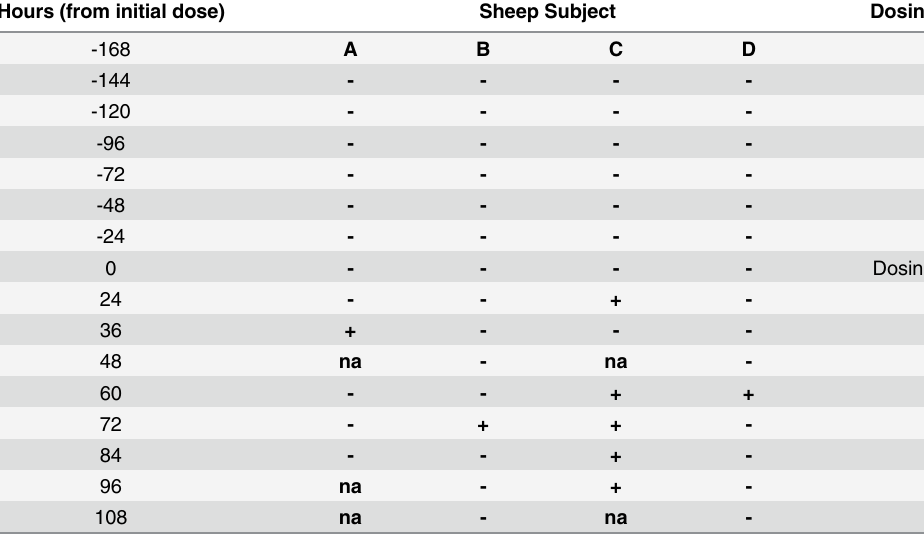
Table 2. Transit of S . fimicola CID 323 through the gastrointestinal tracts of sheep after dosing with live cells of the fungus via esophogeal tube. Hours (from initial dose) Sheep Subject Dosing